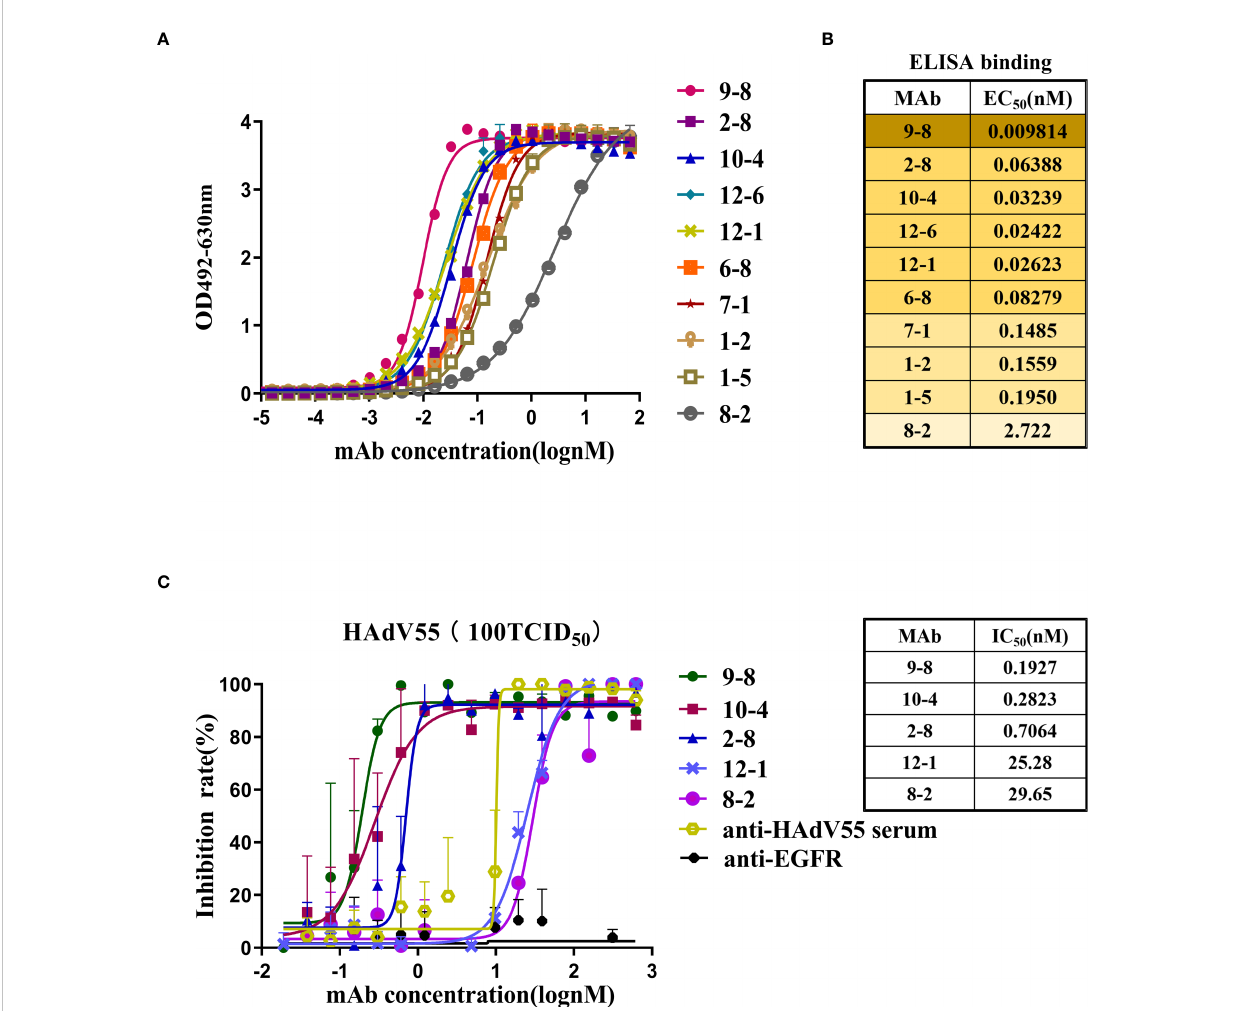
FIGURE 2 Pro fi les of the binding and neutralization of mAbs toward HAdV55. (A) Curves showing the binding between all mAbs and HAdV55. (B) ELISA data- generated heatmap showing the binding between the mAbs and HAdV55 (n = 3 independent experiments). (C) Neutralization assay of the chimeric antibodies, 9-8, 10-4, 2-8, 12-1, and 8-2 toward viruses. Data are shown as the mean ± SD (n = 3 independent experiments). Nonlinear regression analysis was used to obtain the IC 50